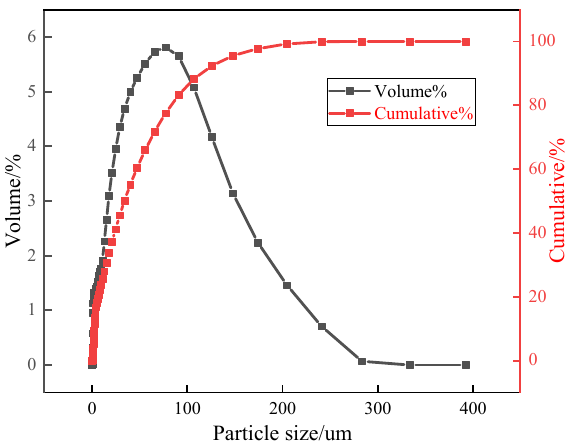
Figure 3. Laser particle size results of zinc ‐ bearing dust samples.